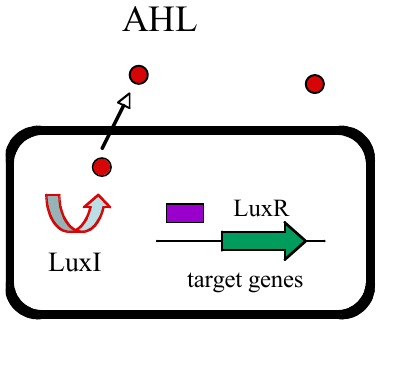
Figure 1. The LuxI/LuxR–type quorum sensing in Gram-negative bacteria. The LuxI-like protein is an autoinducer synthase that catalyzes the formation of a specific acyl-homoserine lactone (AHL). The AHL freely diffuses through the cell membrane at high cell density. The LuxR is a transcriptional regulator that binds to the diffusing AHL and in turn activates the transcription of its target genes. AHL AHL